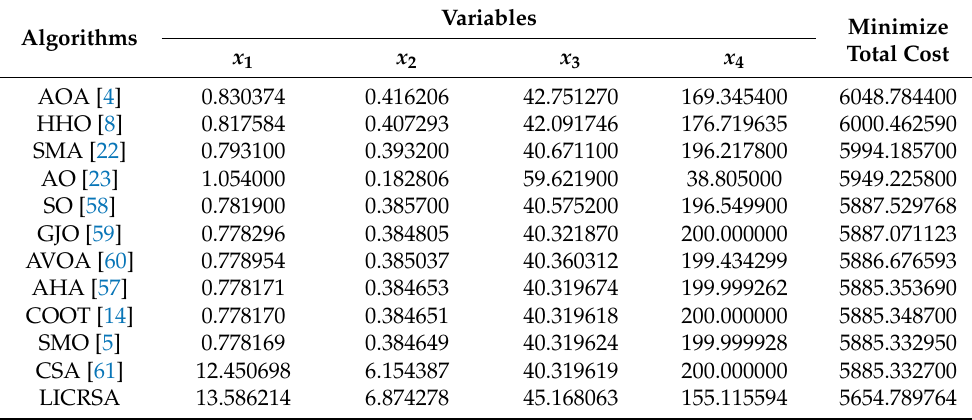
Table 12. Numerical comparison of the results obtained for the pressure vessel in the literature. Algorithms